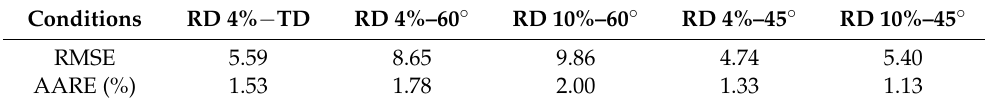
Table 5. Prediction errors for EDDQ under different two-step uniaxial